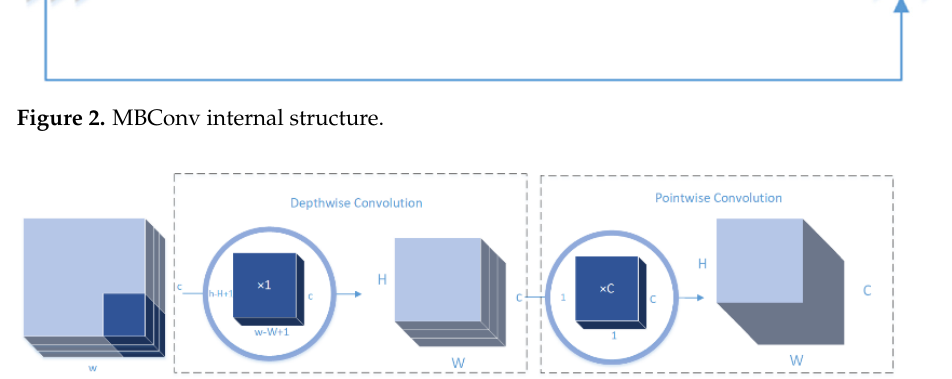
Figure 3. Depth-separable convolution.